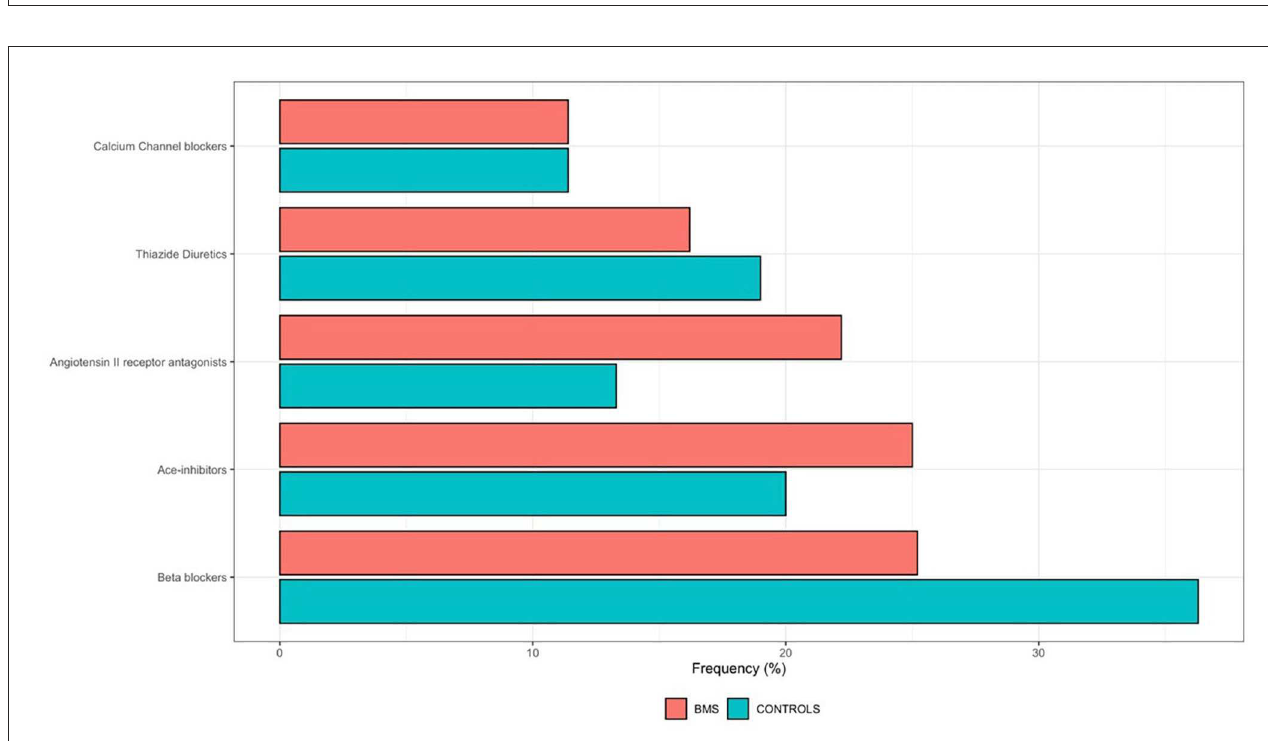
FIGURE3 Frequency distribution of the antihypertensive drugs among 250 WBMS and 250 HW. HW, healthy women; WBMS, women with BMS.